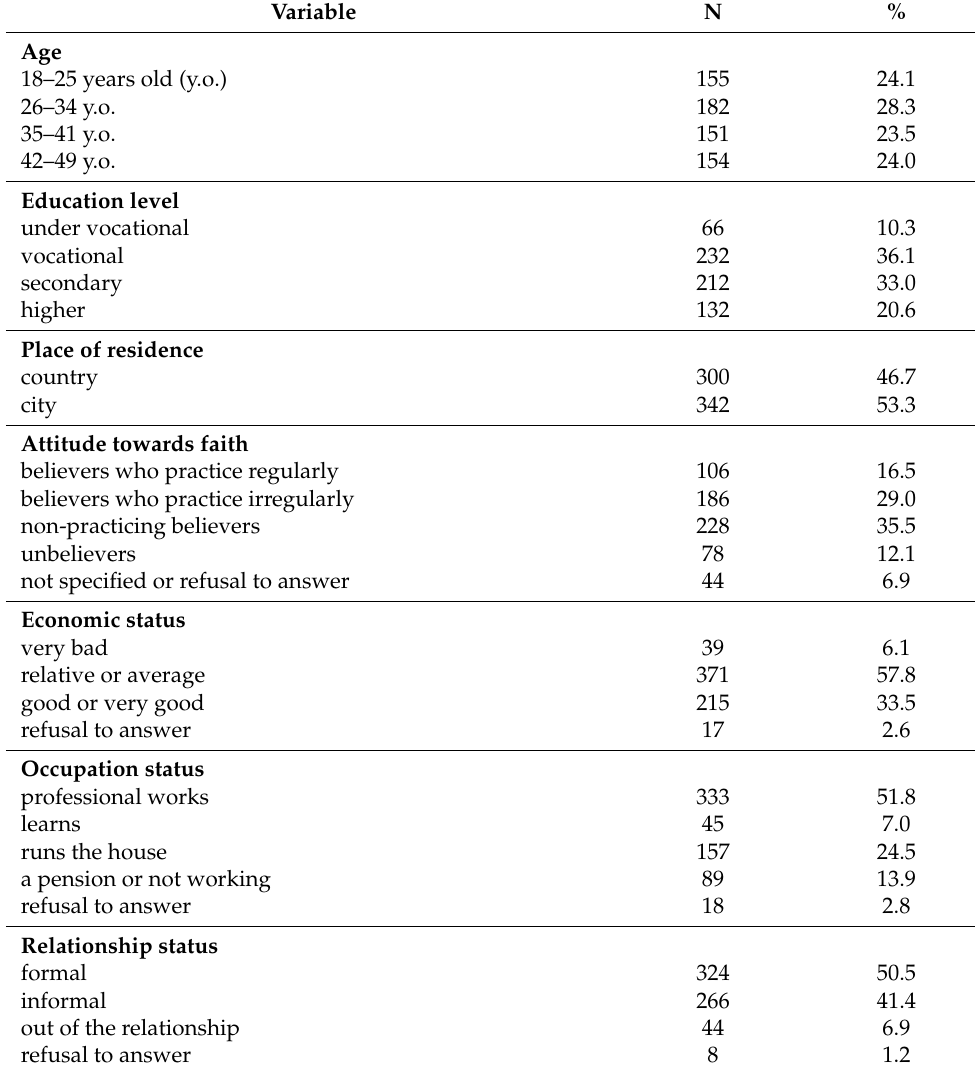
Table 1. Baseline characteristics of the studied population (N = 642).